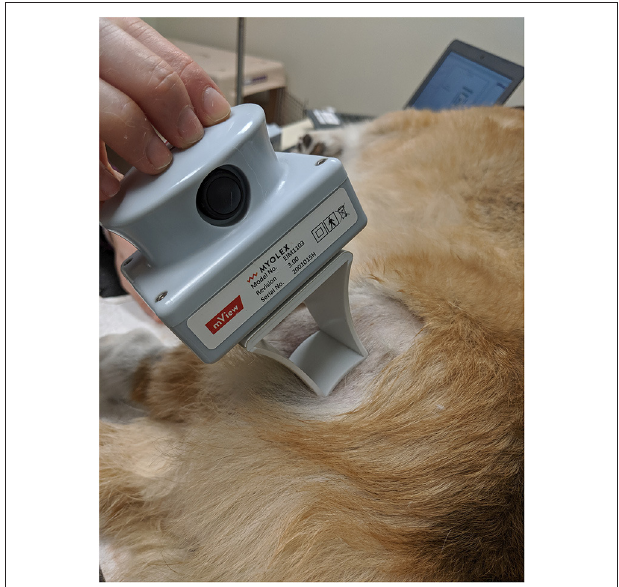
FIGURE 1 | The handheld EIM recording device in place over the biceps femoris. Prior to recording, the fur was clipped and the site moistened with